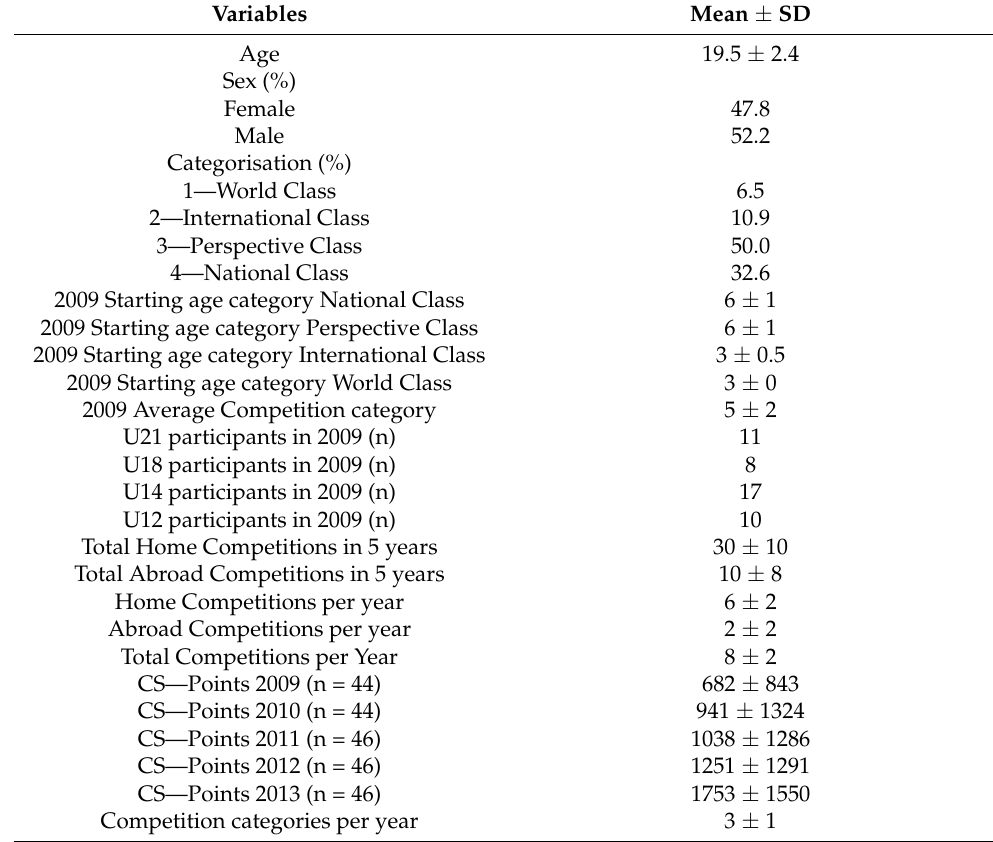
Table 1. Descriptive statistics of the